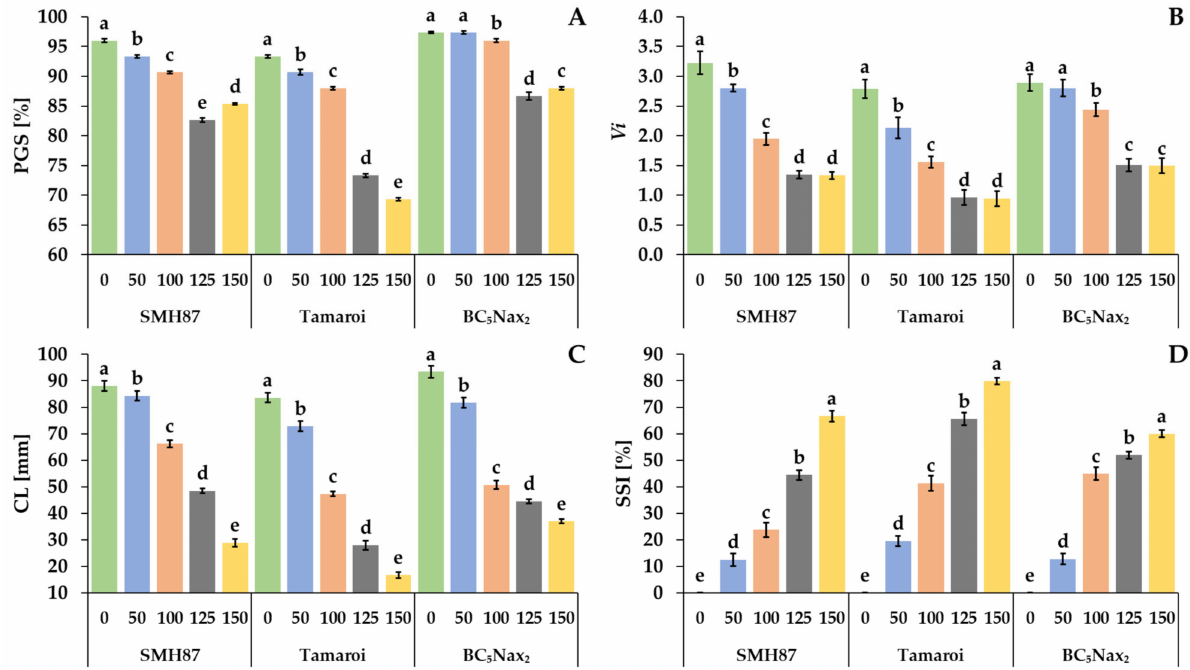
Figure 1. Effects of NaCl treatments (0, 50, 100, 125, 150 mM) on the PGS—percentage of germinated seeds ( A ), Vi —germination vigor index ( B ), CL—coleoptile length ( C ) and SSI—salt susceptibility index ( D ). The values represent means (n = 5) ± SE (standard error) for PGS and Vi ; (n = 20) ± SE for CL and SSI within each accession. Mean values marked with the same letters do not differ statistically according to multiple range Duncan’s test ( p <